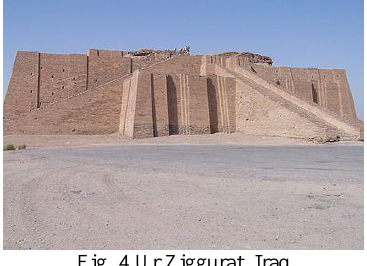
Fig. 4 Ur Ziggurat, Iraq